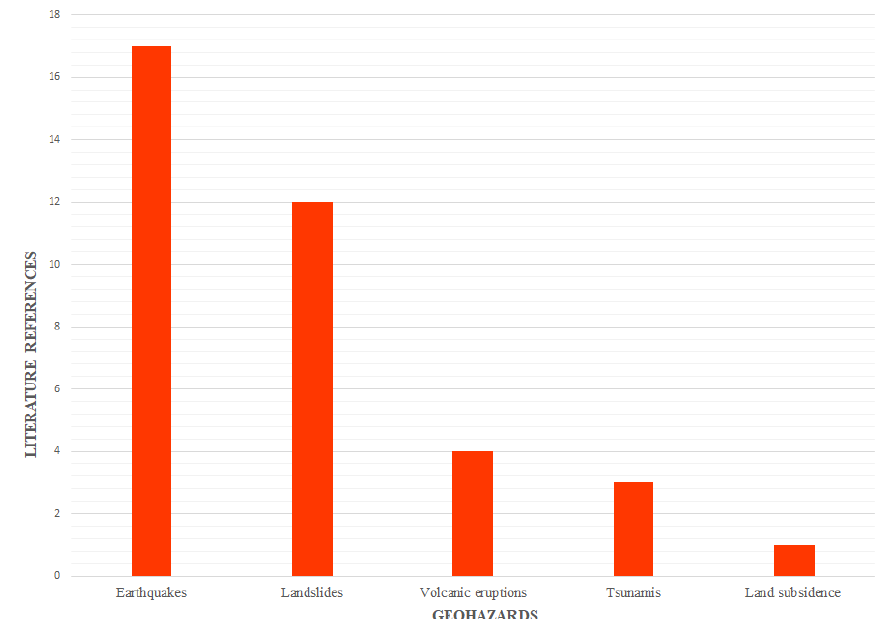
Figure 2. Number of literature references in the systematic review that address each geohazard.